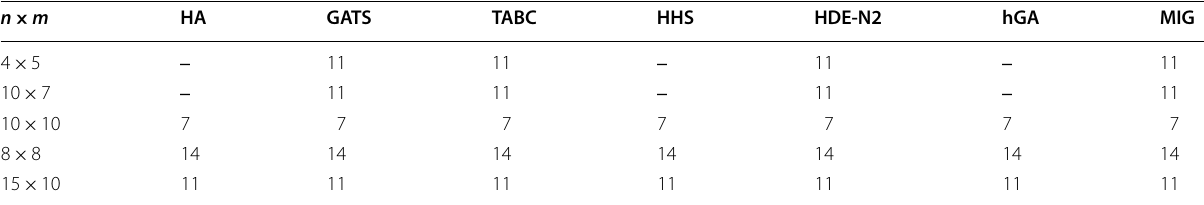
Table 1 Results of Kacem data (experiment